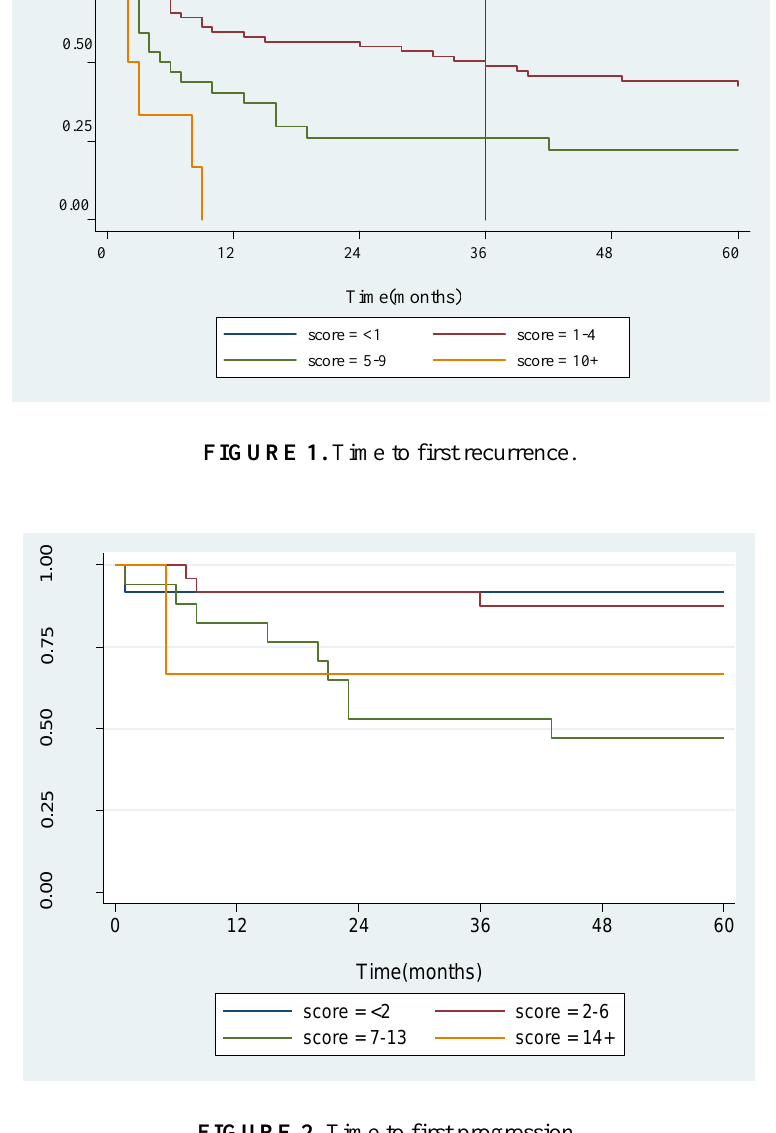
FIGURE 2. Time to first